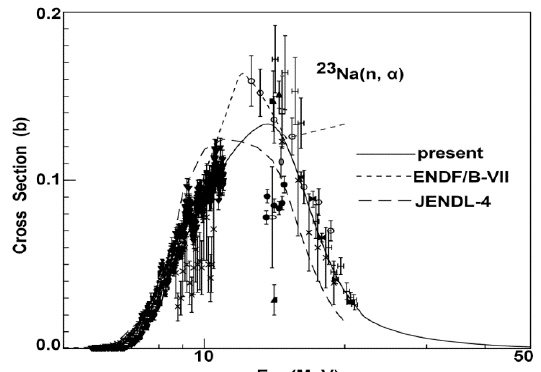
Fig. 9 . The comparison of CENDL-3.2 (solid line) and other evaluated (dashed line) for 23 Na (n, α ) cross section and the available experimental data [13].